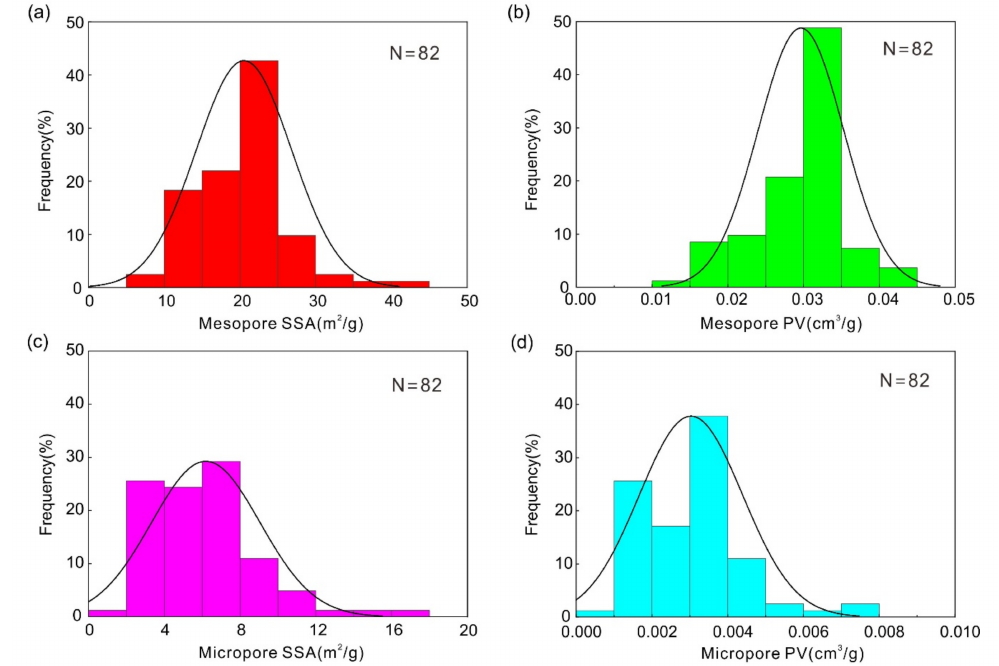
Figure 5. Distribution characteristics of mesopore SSA ( a ), mesopore PV ( b ), micropore SSA ( c ) and micropore PV ( d ) of all shale